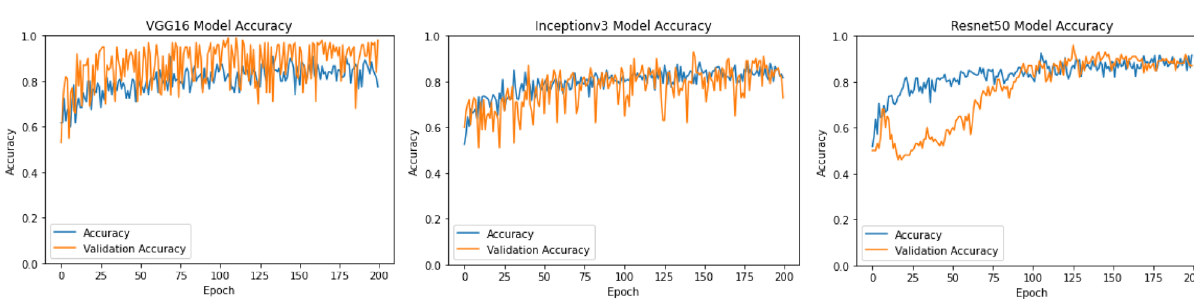
Figure 9. Performance evaluation of deep learning classifier on Brazilian Data-set. S.